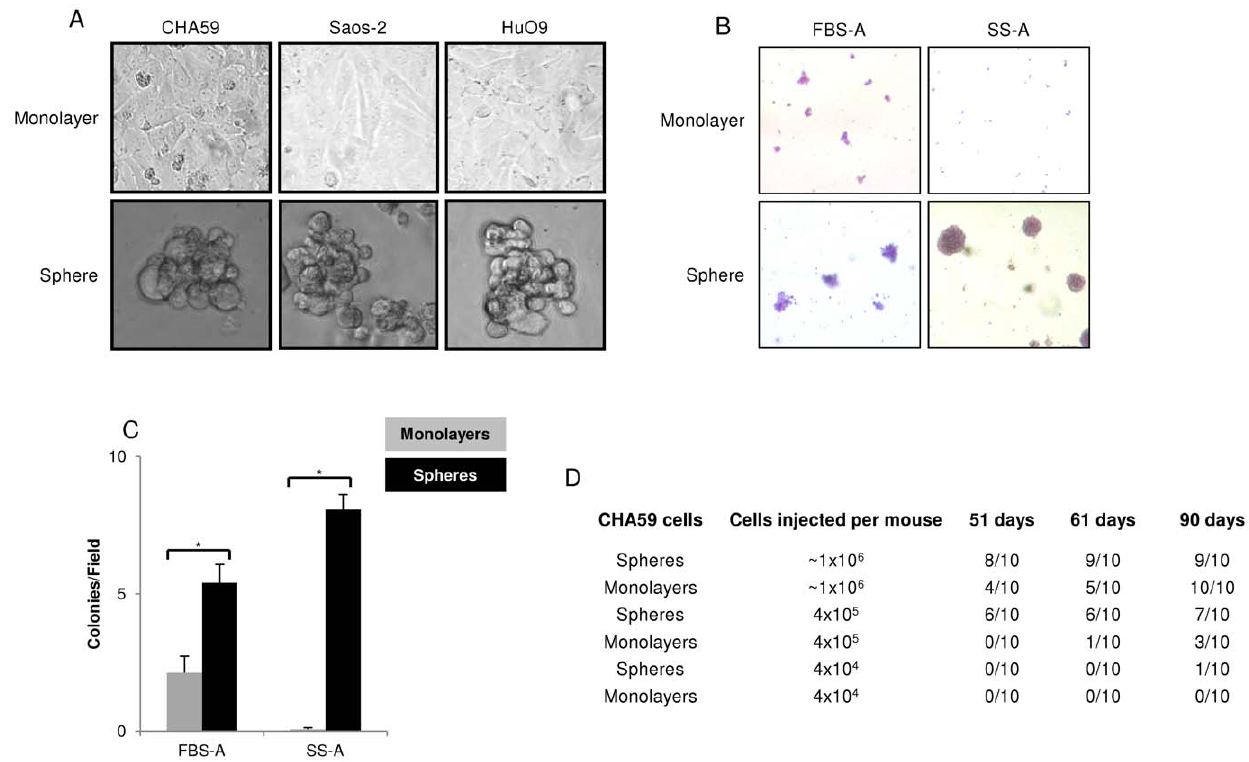
Figure 1. Spheres demonstrated increased clonogenicity and tumorigenicity compared with monolayers. (A) CHA59, Saos-2, and HuO9 monolayers generated spheres in FBS-free, SS media. Phase contrast images taken with a 40 6 objective. (B) CHA59 spheres formed colonies in both FBS-A (Fetal Bovine Serum-Agarose) and SS-A (KnockOut Serum Replacement-Agarose). Images taken with a 10 6 objective. C) CHA59 spheres demonstrated significantly higher clonogenicity as compared with monolayers in FBS-A and SS-A, * p , 0.05. (D) CHA59 Spheres demonstrated higher tumorigenicity than monolayers. 10 NOD/SCID mice injected with cells per group. A xenograft of $ 150 mg was counted positive for take rate.